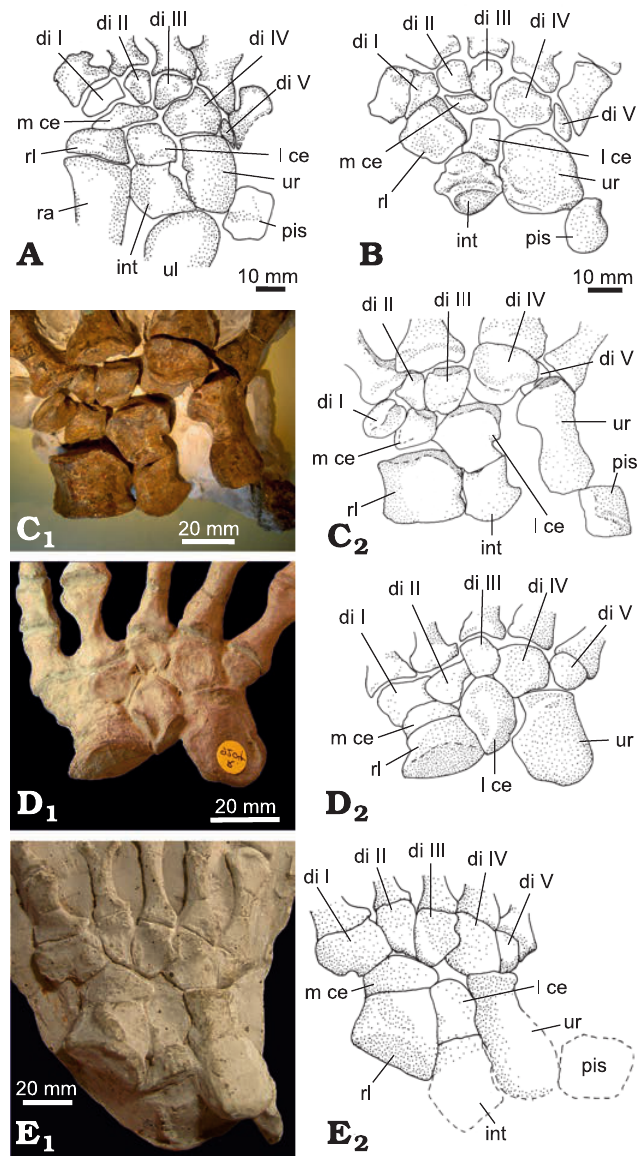
Fig. 3. Carpus of non-therapsid Synapsida. A . Euromycter rutenus (Sigo- gneau-Russell and Russell, 1974), MNHN.F.MCL-2, Valady, France, Sakmarian, left carpus (reversed), dorsal view (redrawn from Sigogneau- Russell and Russell 1974: fig. 18). B . Cotylorhynchus romeri Stovall, 1937, OMNH 00655, Navina, USA, Kungurian, left carpus (reversed), dorsal view (redrawn from Stovall et al. 1966: fig. 13, left). C . Ophiacodon retroversus Cope, 1878, MCZ 1203, Rattlesnake Canyon, USA, Wichita Group, Cisuralian, right carpus, dorsal view. D . Edaphosaurus boan­ erges Romer and Price, 1940, NHMUK R 9204 (cast), Geraldine, Archer County, USA, Wichita Group, Cisuralian, left carpus (reversed), dorsal view. E . Dimetrodon milleri Romer, 1937, MCZ 1365 (cast), Archer, USA, Putnam Formation, Cisuralian, right carpus, dorsal view. Photographs (C 1 – E 1 ) and interpretative drawings (C 2 –E 2 ). Abbreviations: di, distal carpal; int, intermedium; l ce, lateral centrale; m ce, medial centrale; pis, pisiform; ra, radius; rl, radiale; ul, ulna; ur,